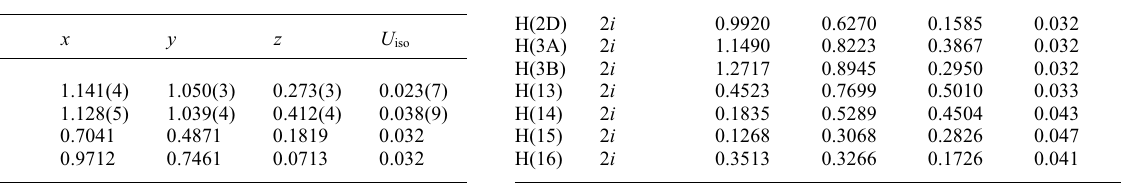
Table 2. Atomic coordinates and displacement parameters (in Å 2 ) .